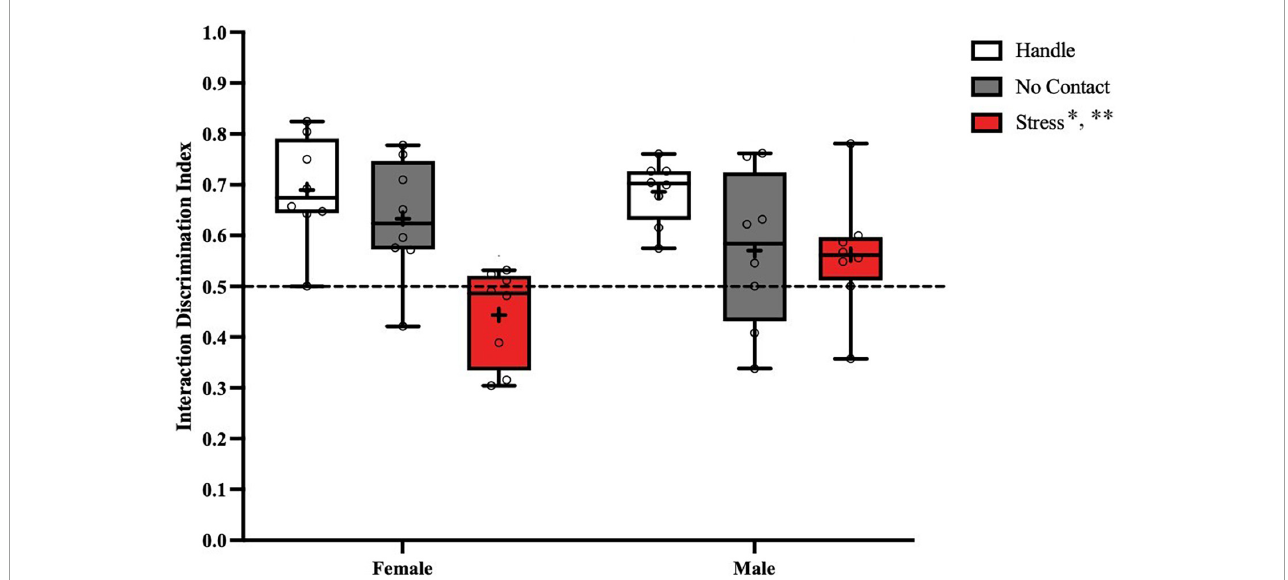
FIGURE6 Preadolescent exposure to a male is associated with reduced social recognition memory in males and females. Both male and female groups exposed to the unfamiliar adult male during preadolescence (P19–P21) showed reduced social recognition memory during postadolescence compared to the home cage control groups ( ∗∗ p < 0.01) and the no contact groups ( ∗ p < 0.02).